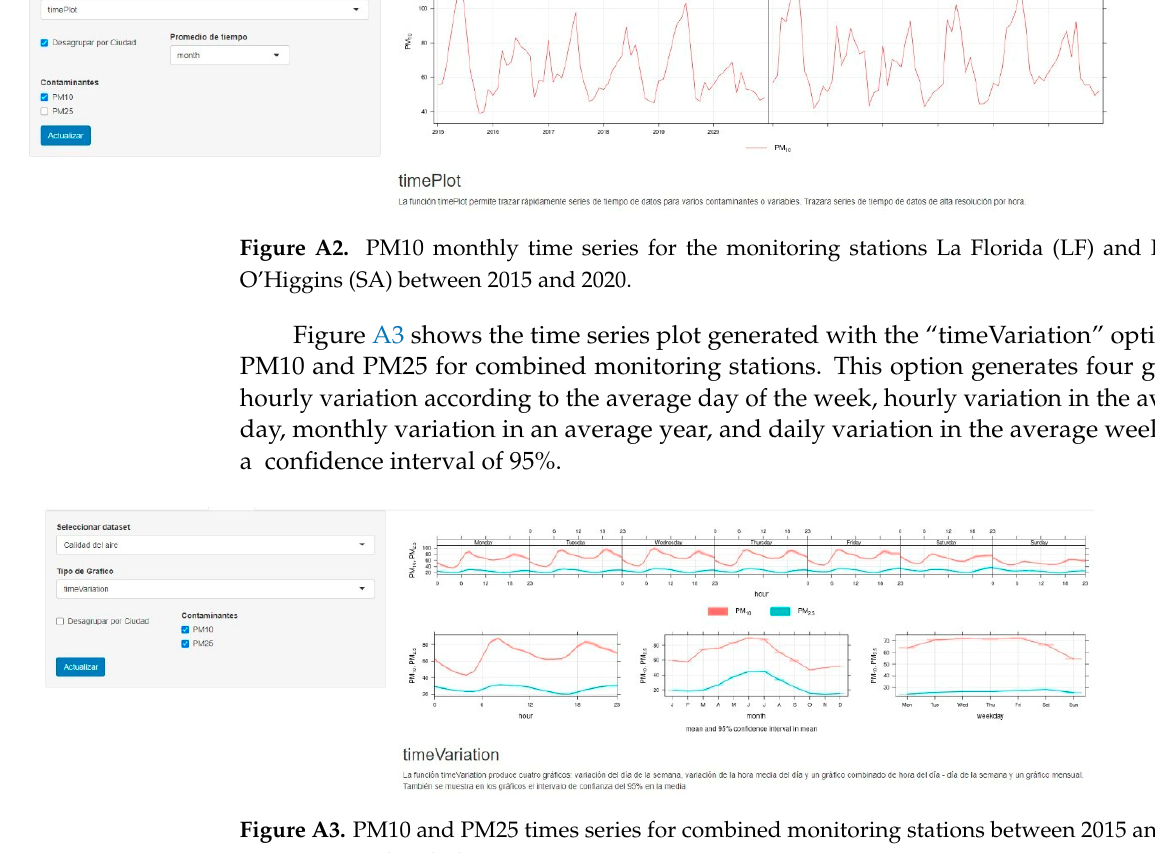
Figure A3. PM10 and PM25 times series for combined monitoring stations between 2015 and 2020 were generated with the timeVariation option.